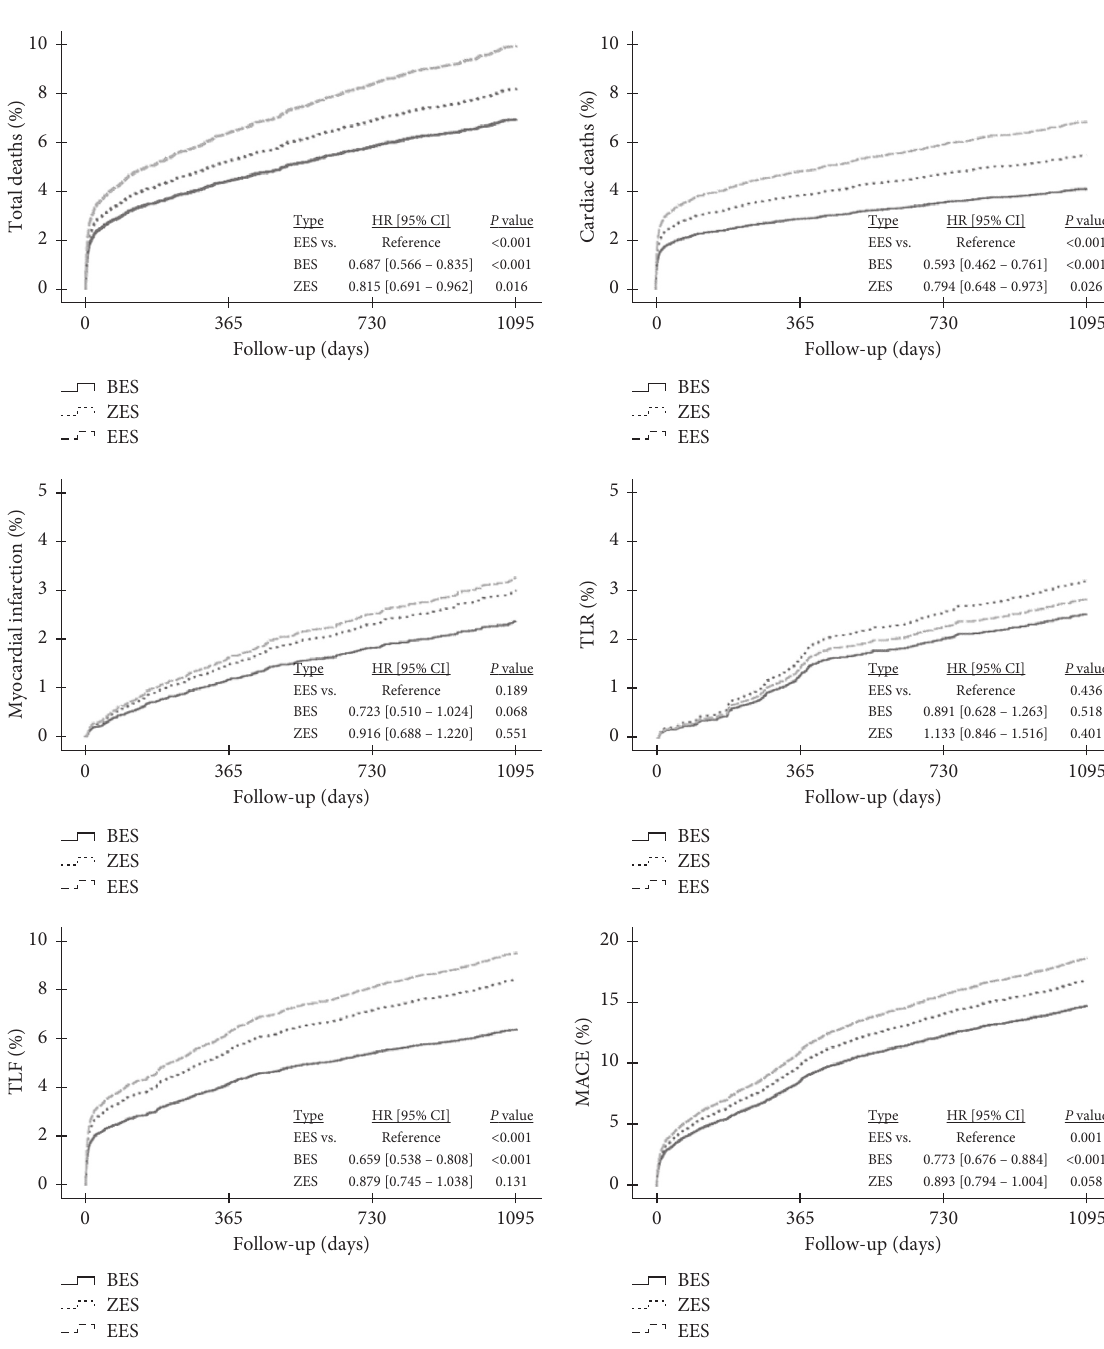
Figure 2: Inverse probability of treatment weighting score-adjusted survival curves from Cox-proportional hazards models for total death, cardiac death, recurrent MI, TLR, TLF, and MACE according to the type of DESs in the overall population. HR, hazard ratio; CI, confidence interval; BES, biolimus-eluting stent; EES, everolimus-eluting stent; ZES, zotarolimus-eluting stent; MI, myocardial infarction; TLR, target lesion revascularization; TLF, target lesion failure; MACE, major adverse cardiac